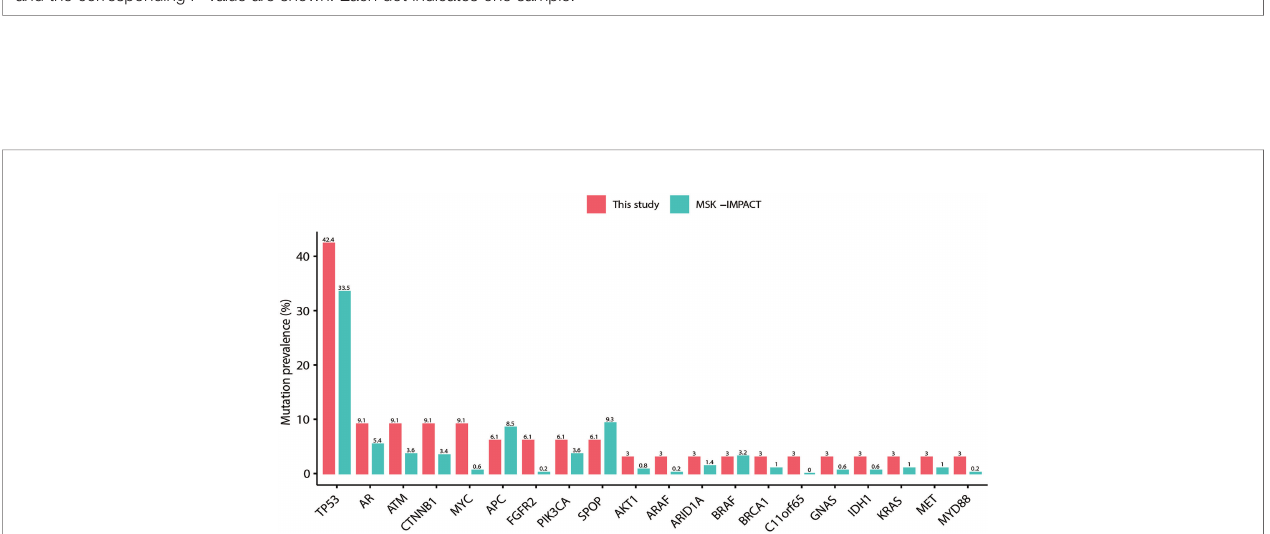
FIGURE 3 | Detection of gene mutation prevalence in plasma cfDNA samples. The plasma spectrum of alterations in this study was almost identical and correlated with tissue samples in the MSK-IMPACT Clinical Sequence Cohort of prostate cancer (37 vs. 504 samples).